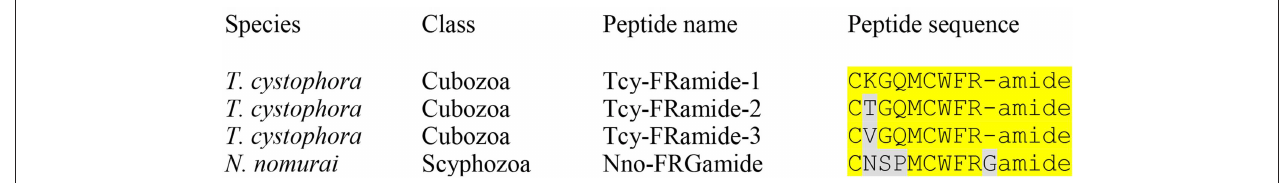
FIGURE 2 | Alignment of the cyclic FRamide peptides from the cubozoan T. cystophora and the scyphozoan N. nomurai. Amino acid residues that are in common with the cubozoan sequence CKGQMCWFRamide, named Tcy-FRamide [see Table 1 from Nielsen et al. (31)] are highlighted in yellow. Please note that the peptides are cyclic after the cysteine residues have formed a cystine bridge and that the resulting “loops” are six-rings with the same size in all peptides.